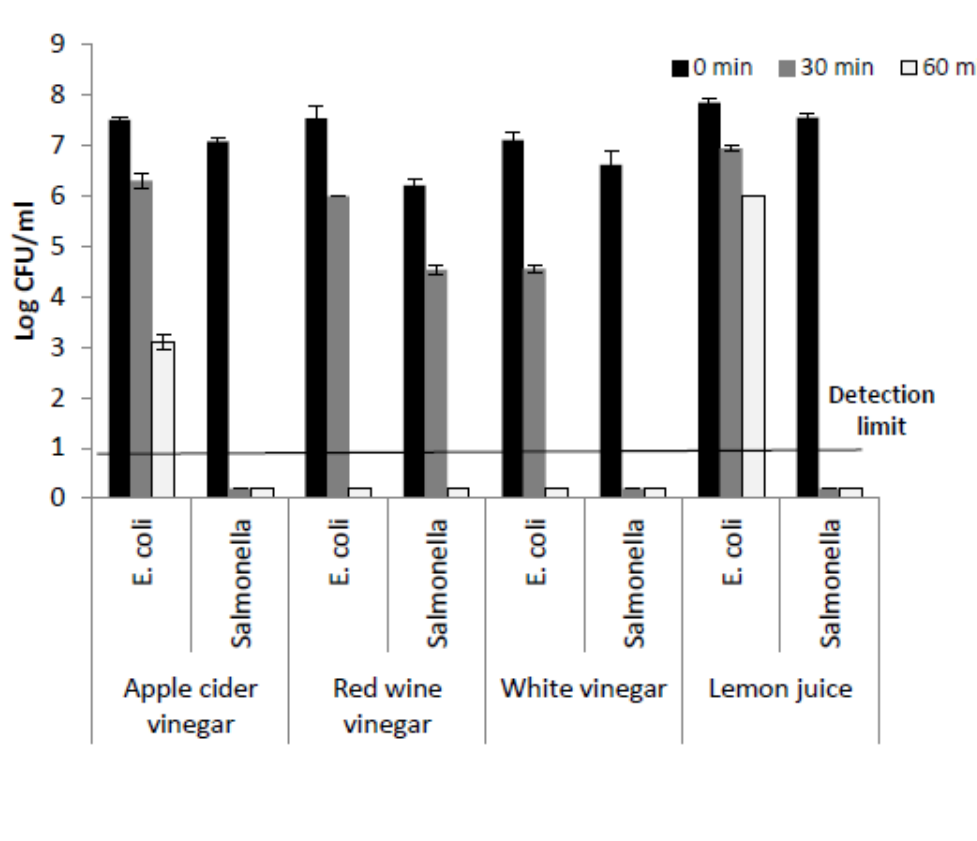
Figure 3. Efficacy of various undiluted vinegar types (white (pH 2.4), apple cider (pH 3.10), red wine (pH 2.73) and undiluted lemon juice (pH 2.57) on E. coli and Salmonella in vitro